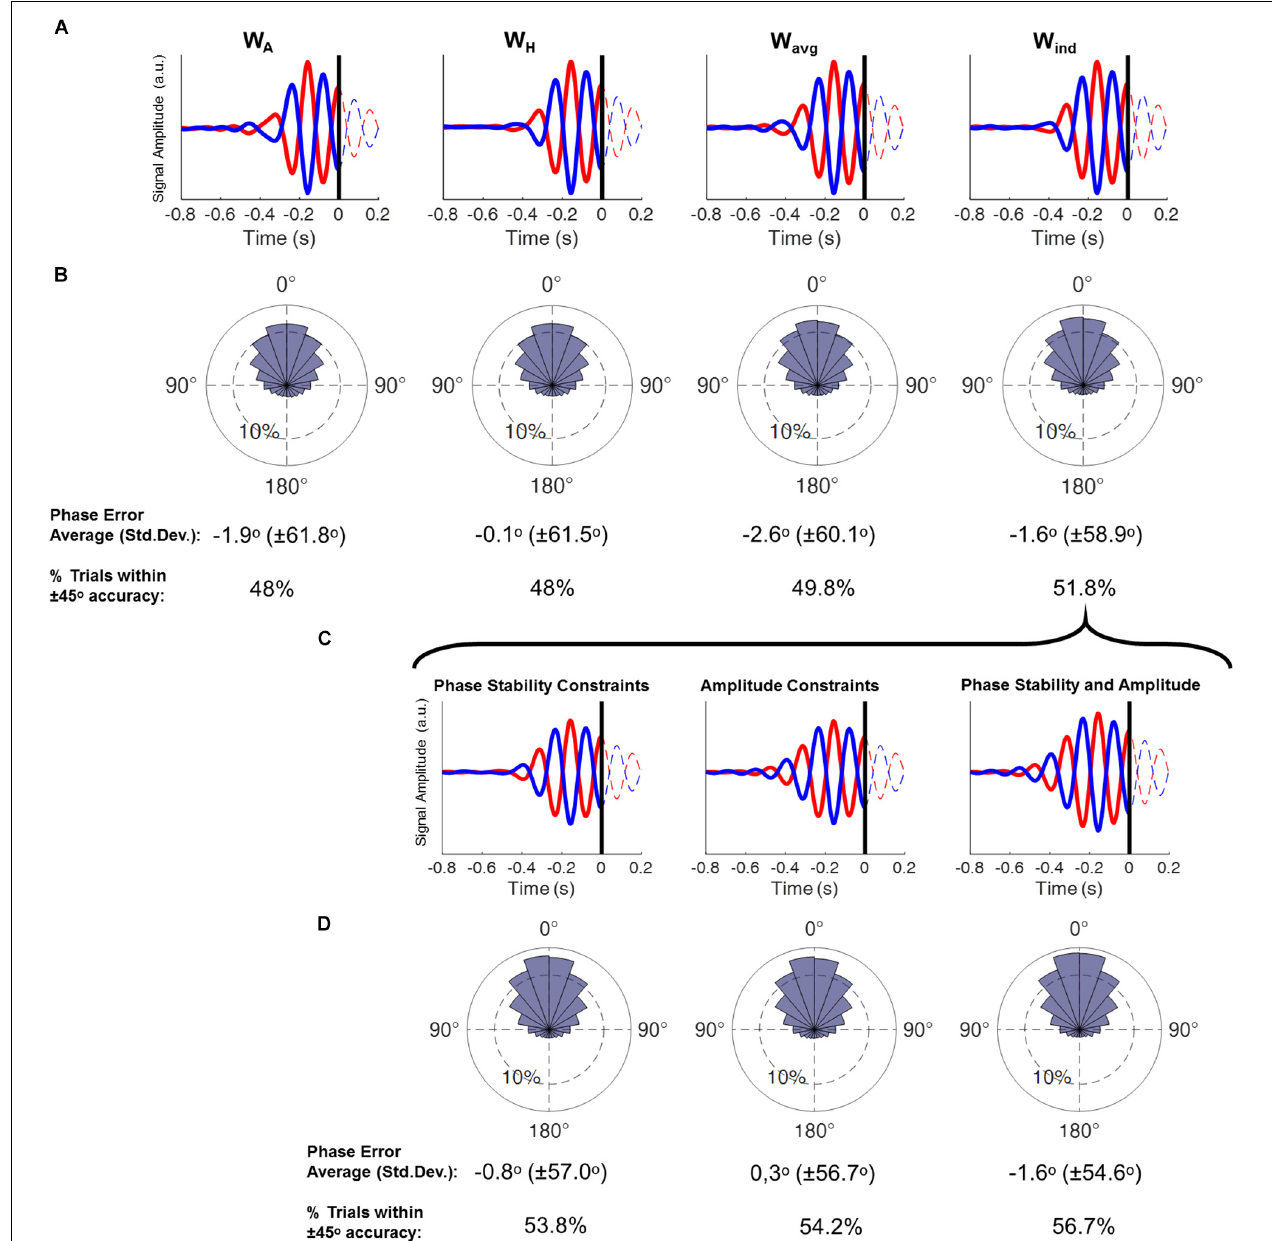
FIGURE 3 | (A) Time course plots display the averaged epochs obtained by running the real-time phase detection algorithm with resting-state EEG, with data obtained by using each spatial filter. Here only trials that were classified as positive peak (red) and negative peak (blue) were included. Time = 0 refers to the time point the theta phase was being estimated. Columns display the results from each spatial filter. (B) Phase histograms show the accuracy of the phase estimation from each spatial filter, obtained by subtracting the estimated phase of all epochs by their corresponding “gold-standard” phase (phase-bin width 20 ◦ , inner ring corresponds to 10% of the total trials). Below are the circular averages and standard deviations of the results, and the proportion of epochs within ± 45 ◦ accuracy (ANOVA, p = 0.0025; post-hoc W A = W H < W avg < W ind ). (C) Time course plots display the averaged epochs obtained by running the real-time phase detection algorithm with resting-state EEG (as in A ), with data obtained by using the W ind filter and followed by different signal constraints: Phase stability, signal amplitude and both phase stability and amplitude constraints. (D) Phase histograms show the accuracy of the phase estimation (as in B ) from the signal after application of each constraint (ANOVA, p = 0.0002; post-hoc [NO constraints] < [phase stability] = [amplitude] < [phase stability AND